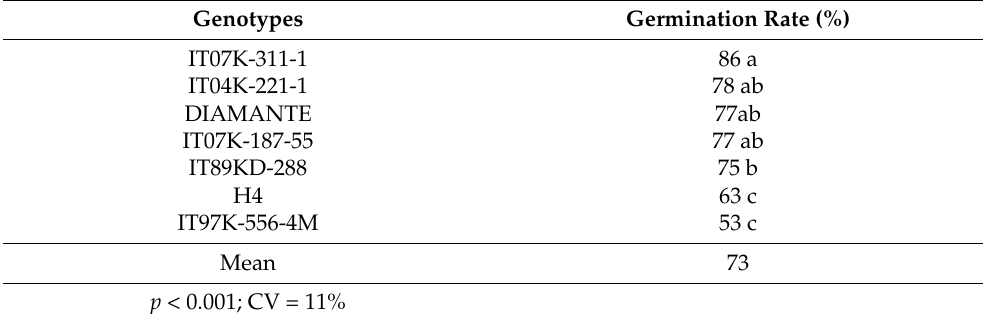
Table 1. Germination rate for examined genotypes. The average of the genotypes indicated by the letters, are not significantly different at the rate level of 5% and coefficient of variation